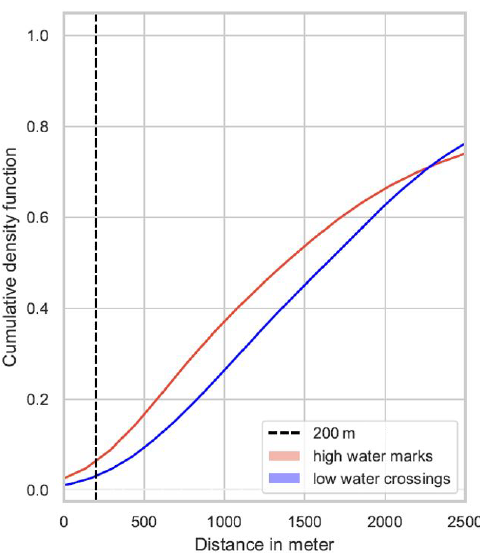
Figure 7. Cumulative density of alert distances to the closest high- water mark and low-water crossing.